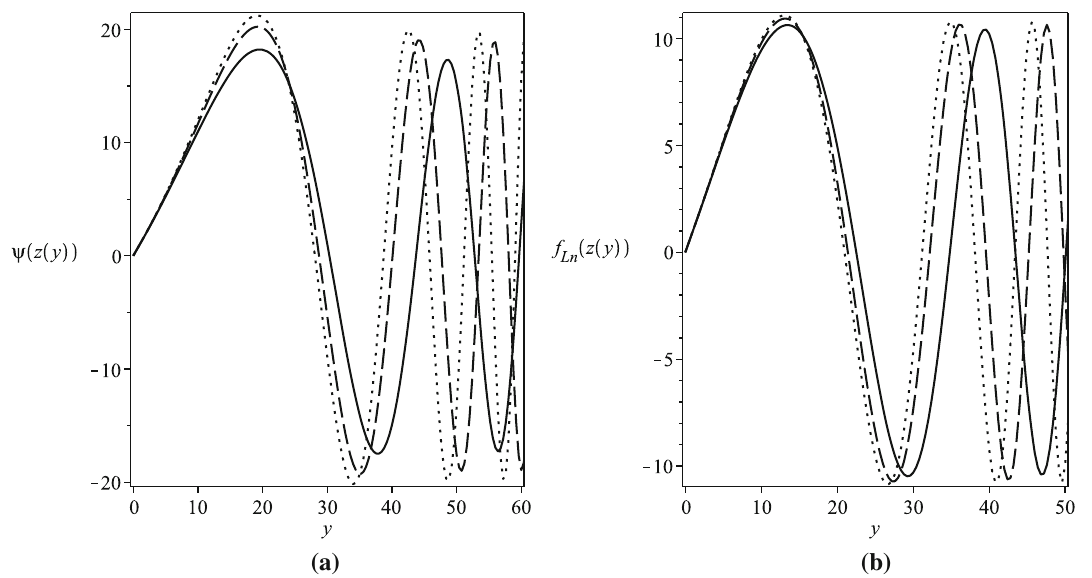
( a ) (b) Fig. 13 The profile of a graviton wave function in f ( T ) gravity and b right-handed fermion wave function in f ( T ) gravity for a = 1 (solid line), a = 2 (dashed line), a = 5 (dotted line), in all cases we set α 0 = 10 and α 1 = 5 and in fermion case we set η =